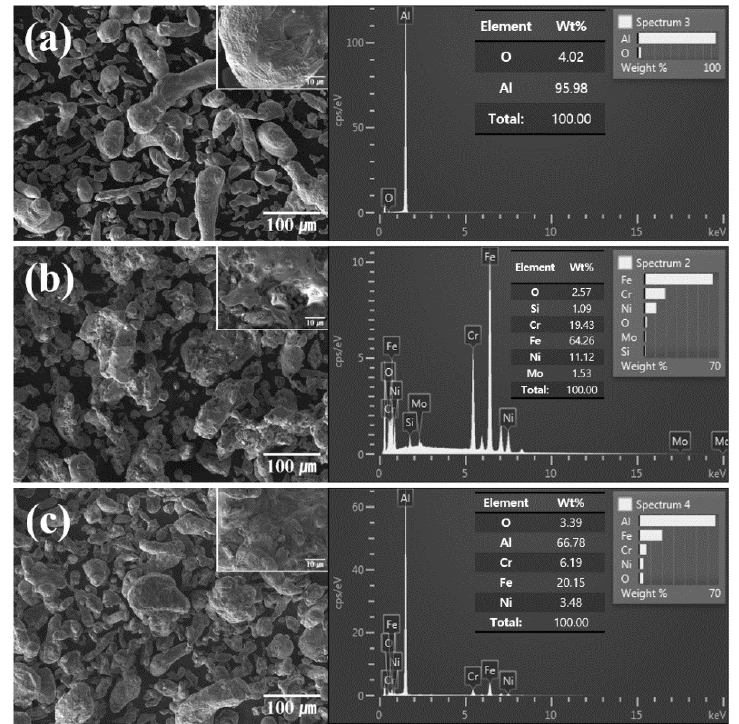
Figure 1. SEM micrograph and EDS spectrum of ( a ) pure Al, ( b ) SUS316L, and ( c ) Al-50 vol.% SUS316L composite powder.